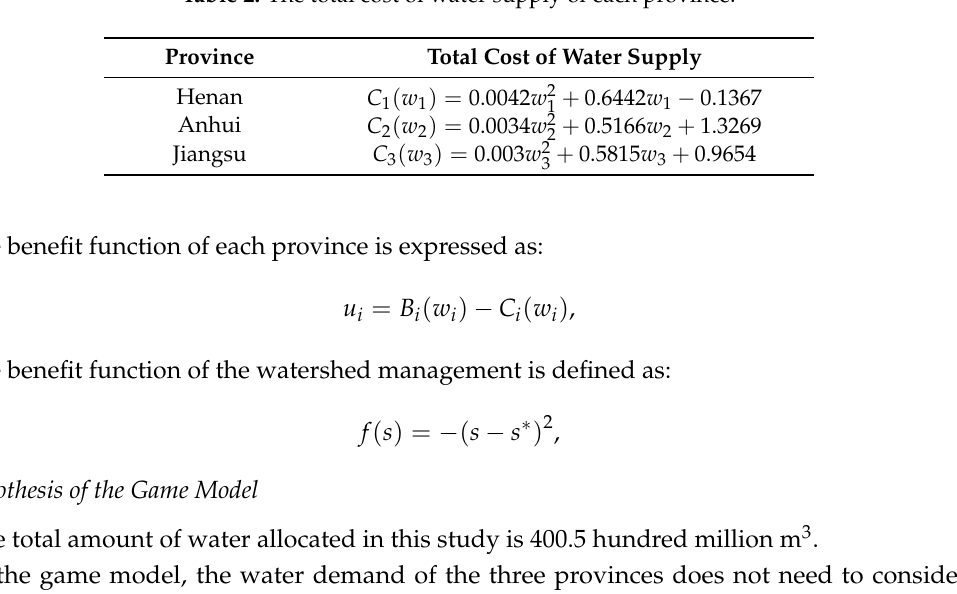
Table 2. The total cost of water supply of each